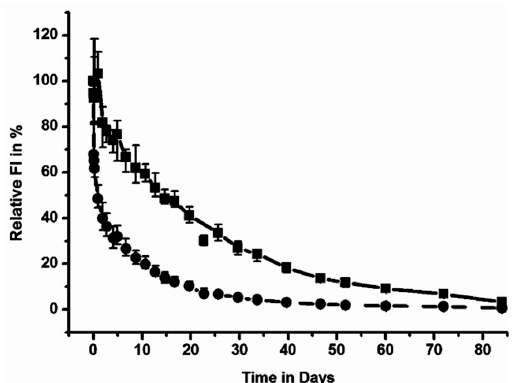
Figure 6. Decrease in the overall fluorescence intensity of HPMA-based copolymers after i.v. administration of 1 mg polymer into healthy SKH-1 mice ( ● ── linear copolymer with M w = 30 000 g/mol; ── star copolymer with M w = 200,000 g/mol). Reprinted with permission from [31]., Copyright [2012], American Chemical Society. Recently, an effective relative method for the evaluation of tumor uptake of DDS was published. The authors defined a tumor accumulation value (TAV) [31] based on the calculation of unmixed grayscale images of the single spectral species based on the fluorescence intensity (I) and fluorescent area. Here, signals from the tumor (I tumor ) and the